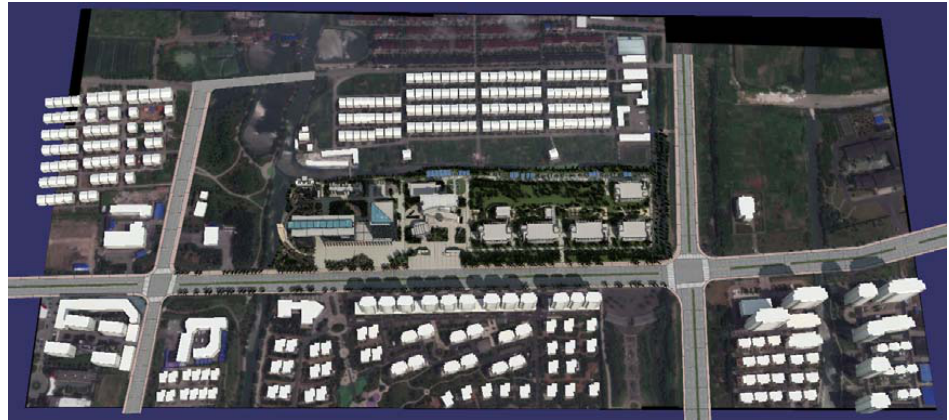
Figure 11. Layout of the Jiashan high-tech park.